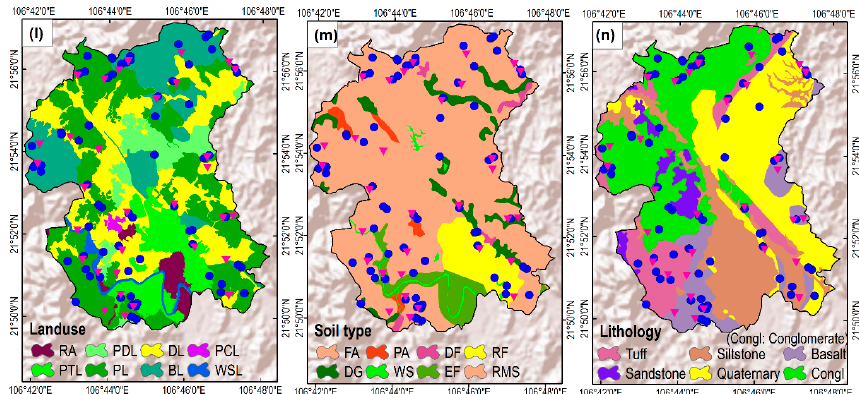
Figure 2. Landslide conditioning factors used in the study area: ( a ) slope, ( b ) slope lengths ( c ) aspect, ( d ) curvature, ( e ) elevation, ( f ) TWI (topographic wetness index), ( g ) SPI (stream power index), ( h ) STI (sediment transport index), ( i ) valley depth, ( j ) topo-shape, ( k ) distance to faults, ( l ) land use, ( m ) soil type, and ( n ) lithology. Explanations of land use and soil type can be found in [52].